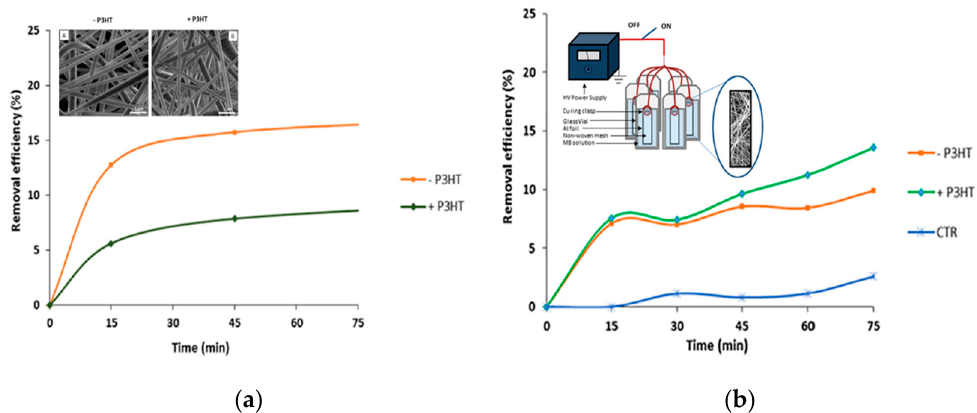
Figure 7. PVDF-TrFE/P3HT composite nanofibers for molecular adsorption. Inset ( a ) Unloaded ( − P3HT) (A) and loaded (+P3HT) (B) nanofibers without ( a ) and with ( b ) the application of an ex- ternal electric field. Inset ( b ): Schematic of the nanofibers system for controlled adsorption. Adapted with permission from